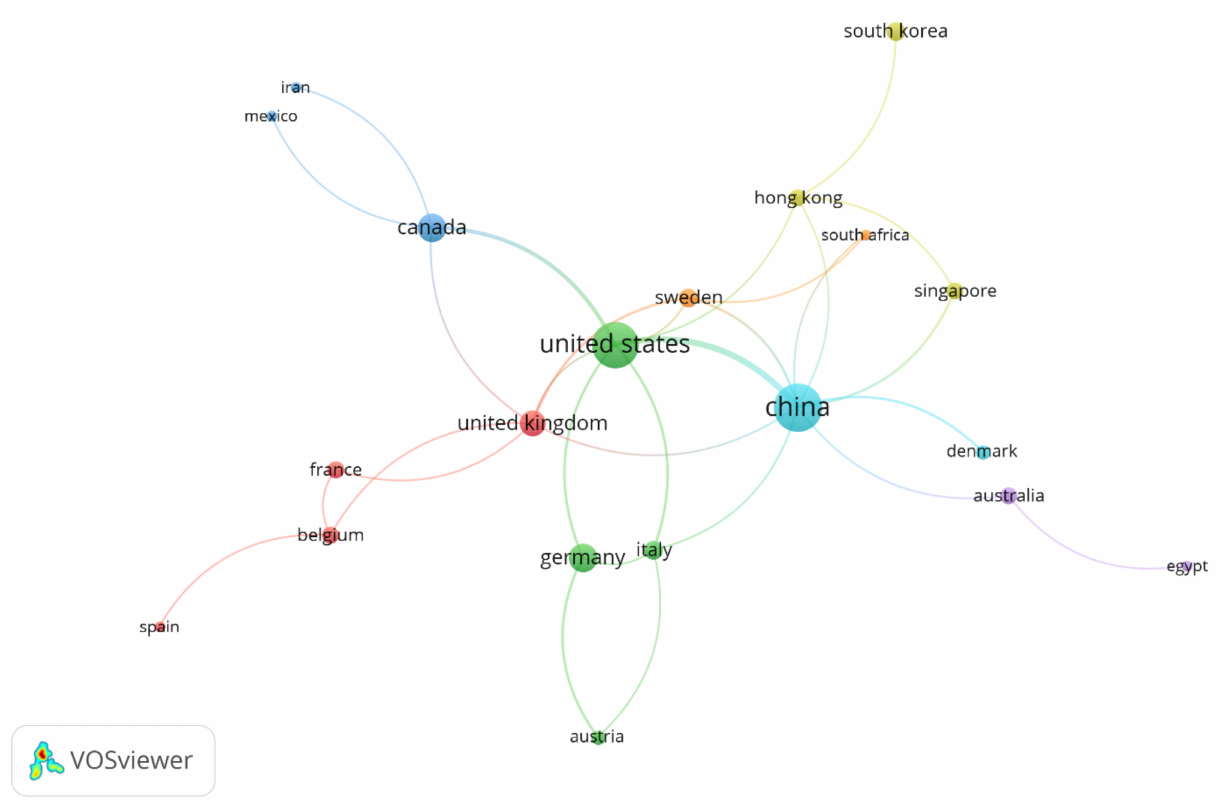
Figure 9. The networking diagram to represent the impact of 14 countries on the publication trend in BMS technology for EV applications.